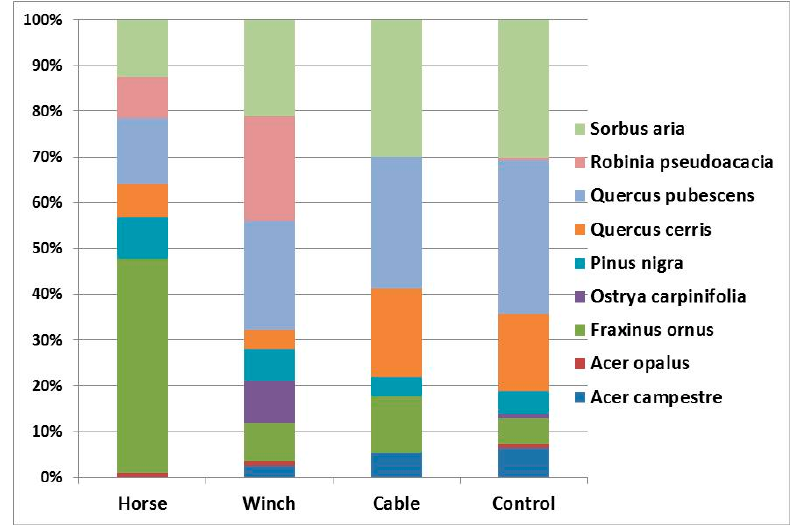
Figure 3. Tree species percentage distribution, average values grouped for logging treatments and control.